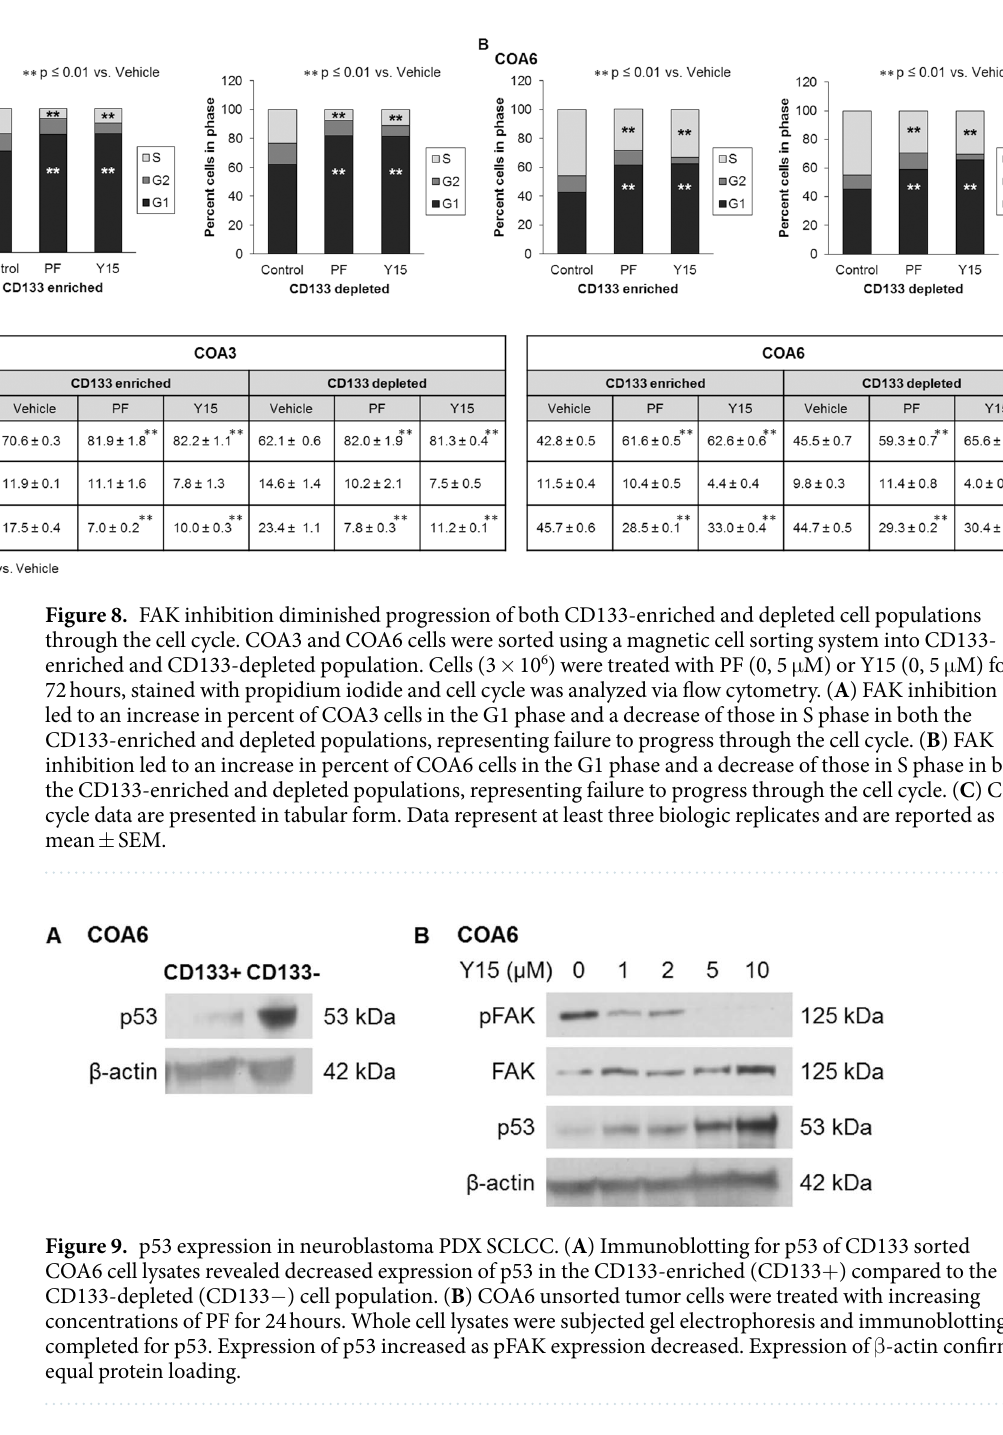
expression of p53 in the CD133-enriched SCLCCs compared to CD133-depleted population (Fig. 9A). We pre- viously demonstrated that inhibition of FAK in long term passage neuroblastoma cell lines led to an increase in